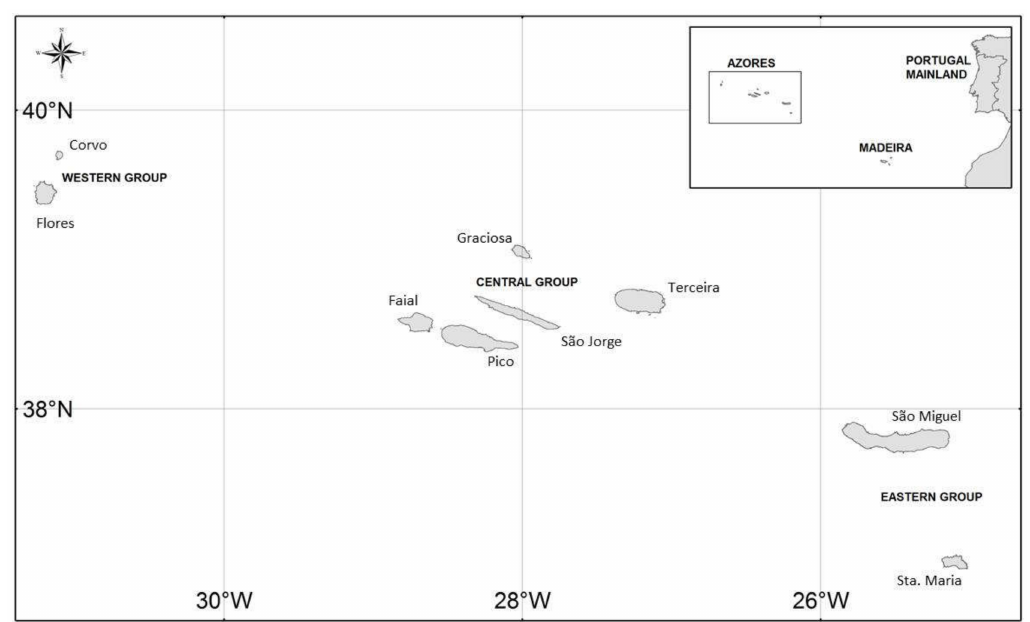
Figure 1. Location of the Azores archipelago in the North Atlantic